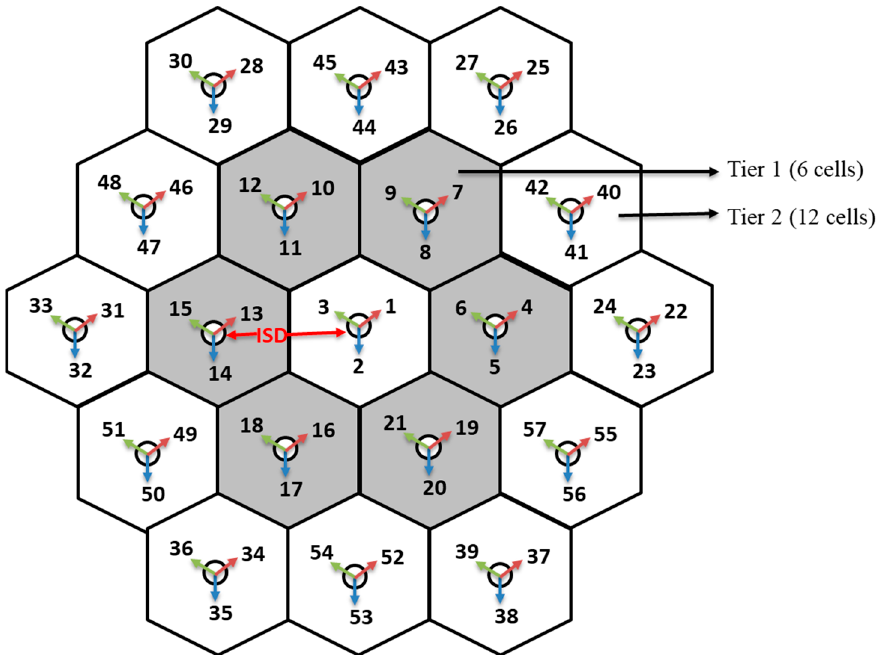
Figure 4. 5G Network layout that has 19 cells, each with three sectors.